Question: What form of chart is displayed?
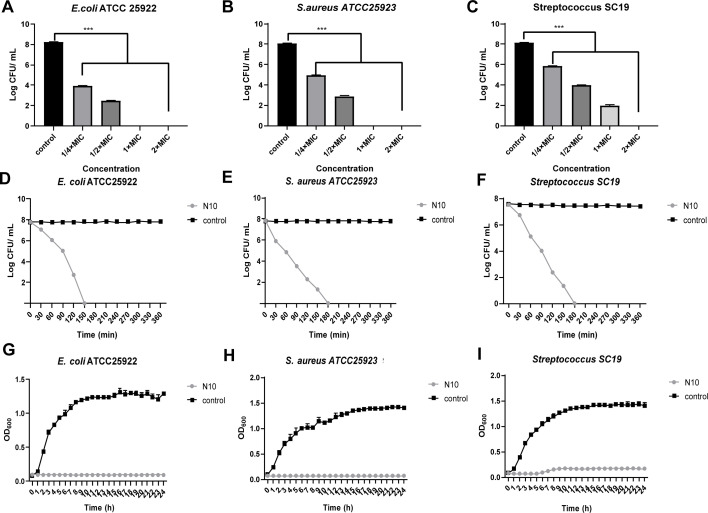
Answer: line